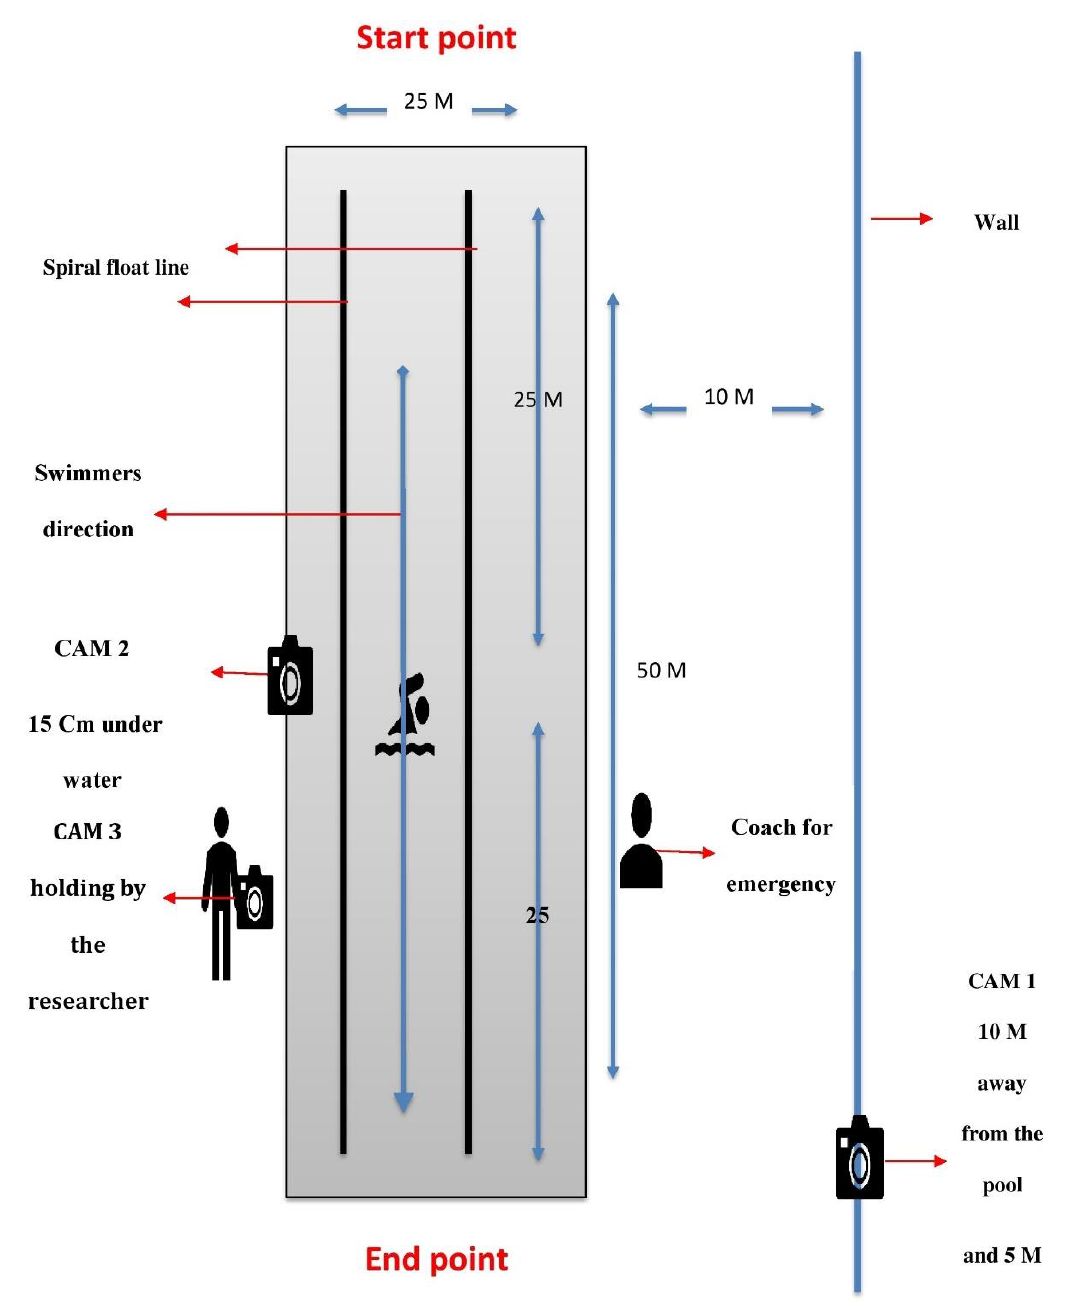
Figure 2. Swimming performance measurements.